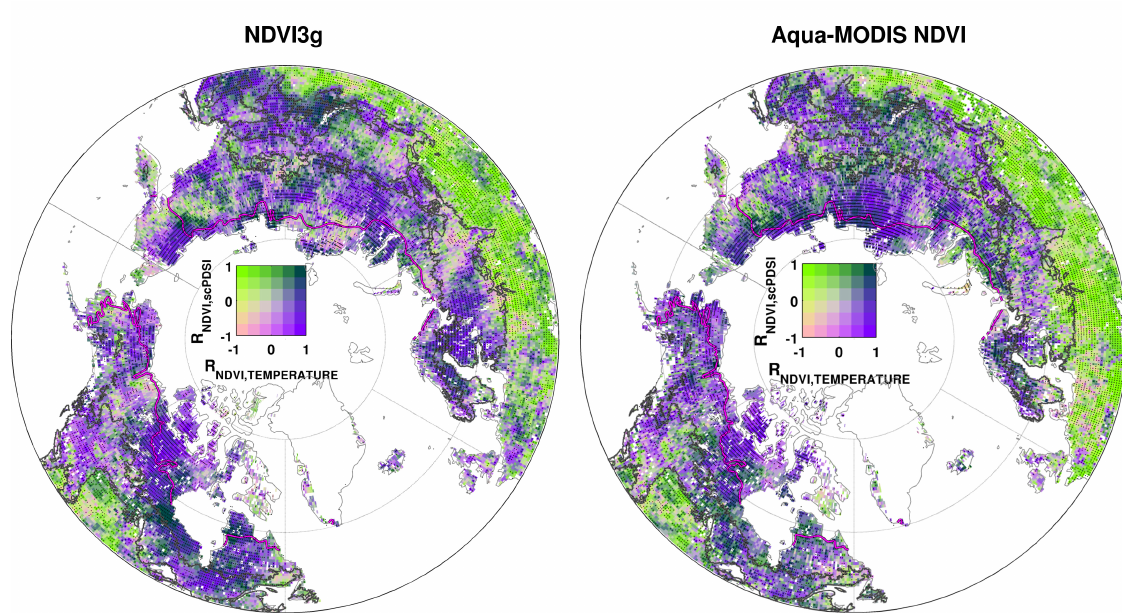
Figure A7. Comparison between maps of climate limitation based on NDVI3g and Aqua-MODIS NDVI during the common period 2002–2009. Each map combines correlations of detrended summer NDVI with detrended summer temperature and scPDSI averaged over spring-summer (March–August). Light greens indicate strong moisture limitation ( i.e. , strong positive correlation with precipitation and negative correlation with temperature), whilst purple shades indicate a dominant temperature limitation ( i.e. , strong positive correlation with temperature and weak correlation with precipitation). The stippling indicates grid boxes where either correlations with temperature or scPDSI are statistically significant ( p < 0.1). Although the significance of these relationships over this very short period is difficult to establish, the spatial patterns are still informative for a comparative purpose. The gray polygons in the maps denote the extent of the boreal